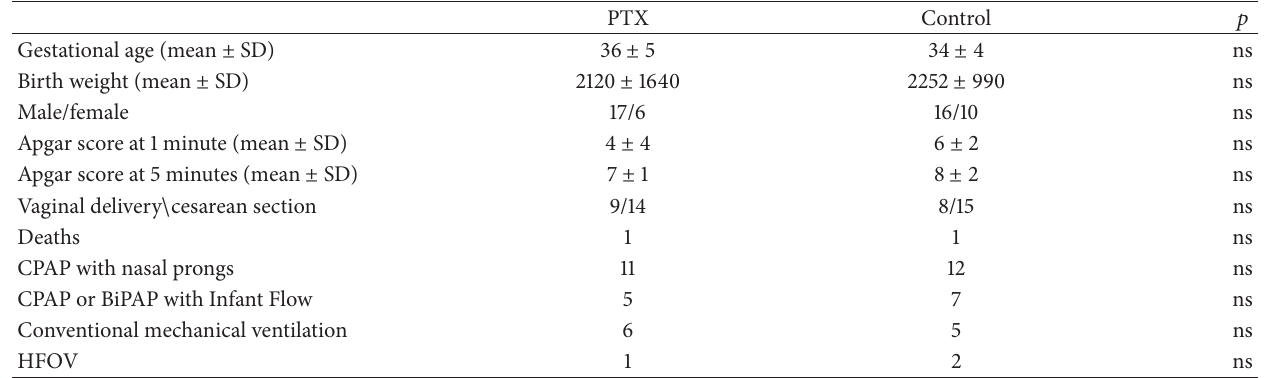
Table 1: Demographic data and type of respiratory support.